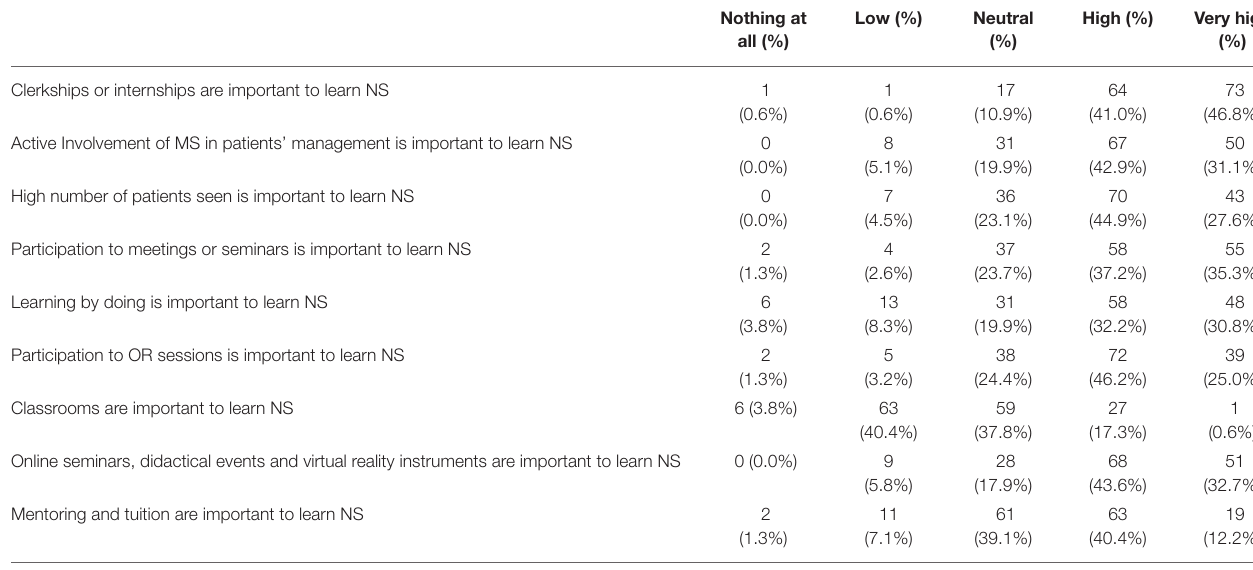
TABLE 5 | Needs in neurosurgical education and training by medical students.